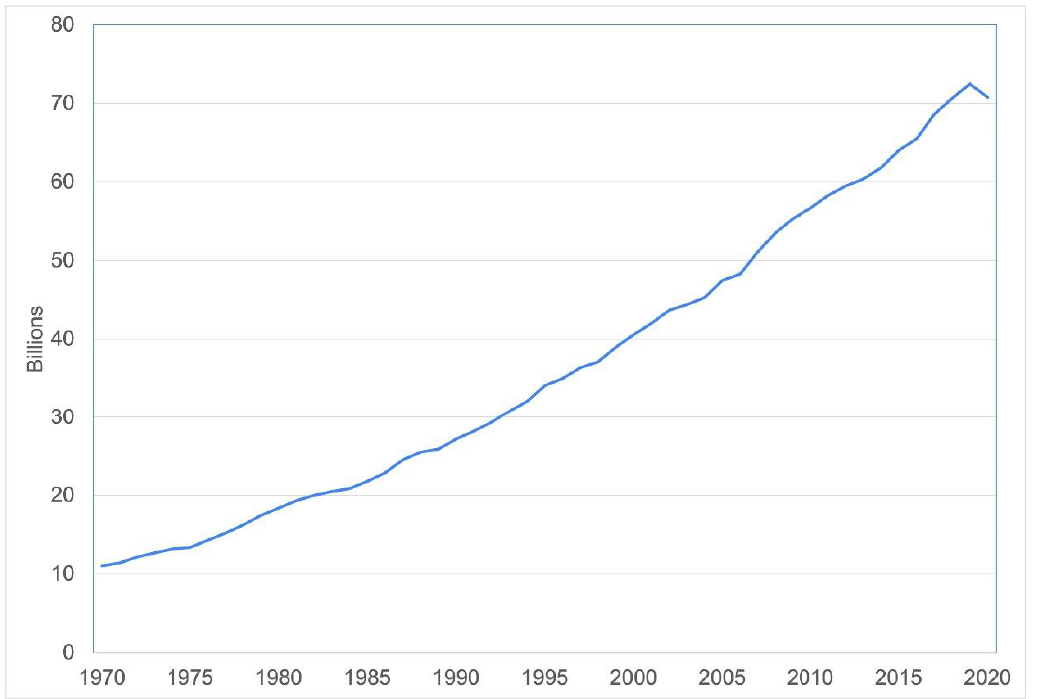
Figure 1. Chickens slaughtered globally. Data source: [1].